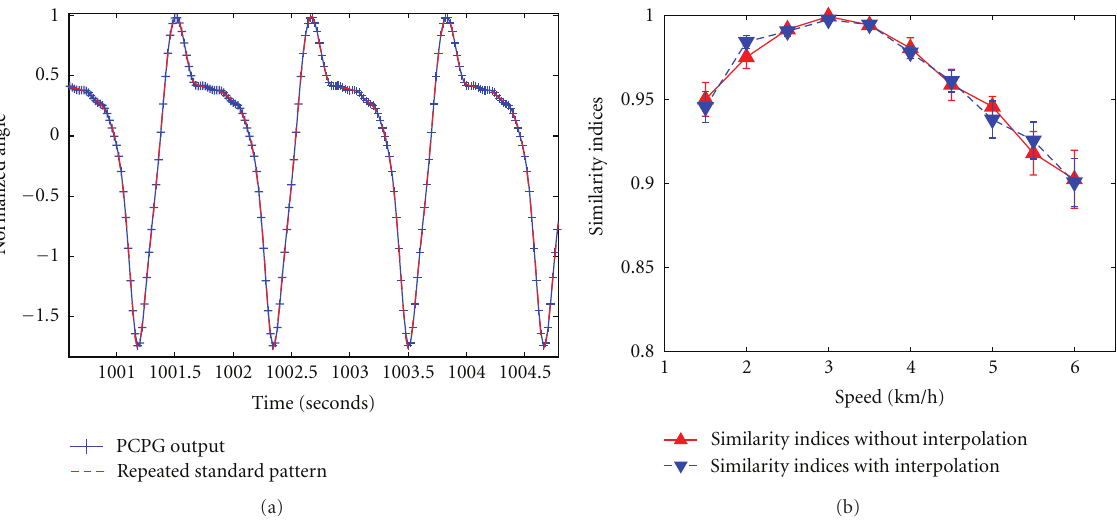
Figure 4: PCPG performance as a function of the walking speed. (a) Superimposition of the real foot elevation angle (red) and the PCPG output (blue) by means of 7 oscillators. (b) The di ff erence between SI values obtained with and without the interpolation is not significant. In this case, error bars are standard errors (modified from Duvinage et al.